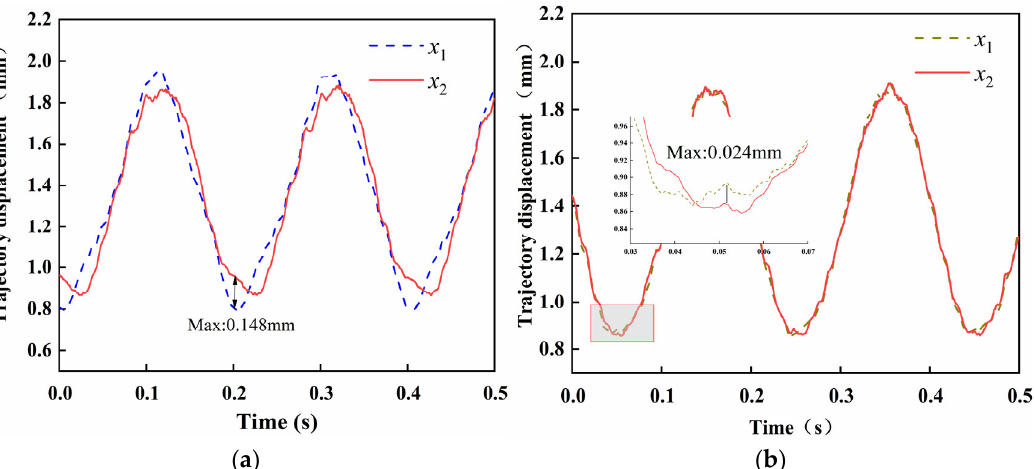
Figure 8. Control system hardware.